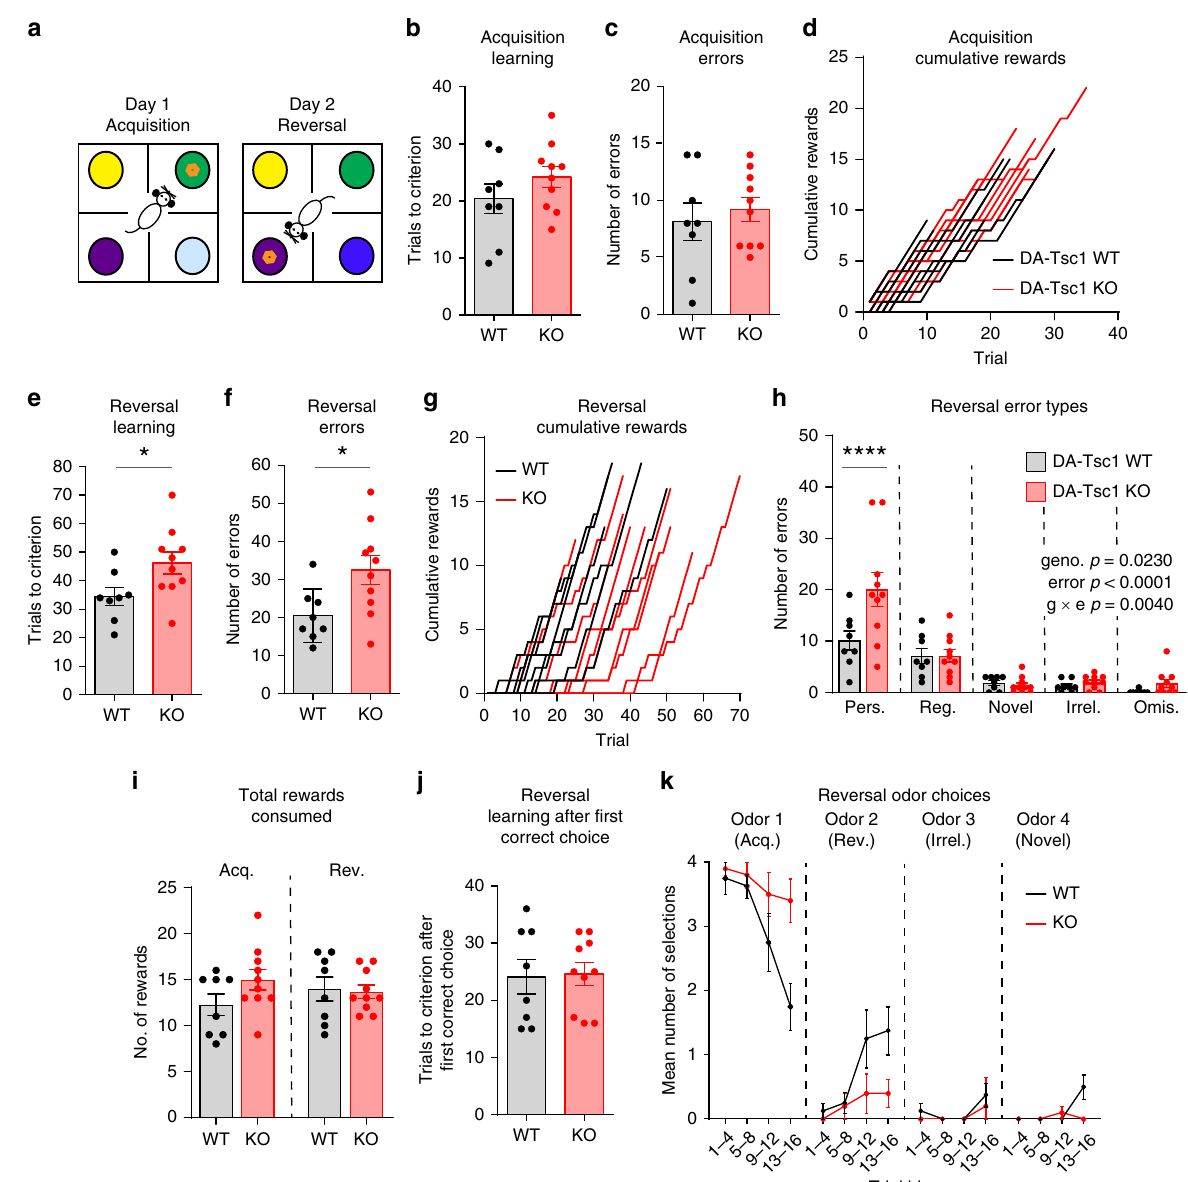
Fig. 7 DA-Tsc1-KO mice exhibit reduced cognitive fl exibility. a Schematic of the four-choice odor-based reversal learning task. Orange ring denotes the food reward. Dark blue circle in Reversal indicates a novel odor. b , c Mean ± SEM number of trials taken to reach criterion (eight out of ten correct) during acquisition learning ( b ) and total errors made during acquisition learning ( c ) in the four-choice test. d Step function cumulative reward plot for individual animals during acquisition learning. e , f Mean± SEM number of trials taken to reach criterion (eight out of ten correct) during reversal learning ( e , * p = 0.0392) and total errors made during reversal learning ( f , * p = 0.0230), unpaired, two-tailed t tests. g Step function cumulative reward plot for individual animals during reversal learning. h Analysis of different error types during reversal learning. Bars represent mean ± SEM number of perseverative (Pers.), regressive (Reg.), novel, irrelevant (Irrel.), or omission (Omis.) errors for mice of each genotype. Two-way ANOVA p values are shown. **** p < 0.0001, Sidak ’ s multiple comparisons test. i Mean ± SEM total number of rewards obtained and consumed during acquisition (Acq.) and reversal (Rev.) learning. j Mean ± SEM and number of trials to reach criterion (eight out of ten correct) during reversal learning after the fi rst correct selection of the newly rewarded odor. k Mean± SEM number of odor selections in bins of 4 trials during reversal learning. Odor 1 is the odor rewarded during acquisition learning and odor 2 is the odor rewarded during reversal learning. For all panels DA-Tsc1-WT: n = 8 male mice and DA-Tsc1-KO: n = 10 male mice. For all bar graphs, dots represent values for individual mice. See Supplementary Table 5 for p values for all behavior tests. Source data are provided as a Source Data fi